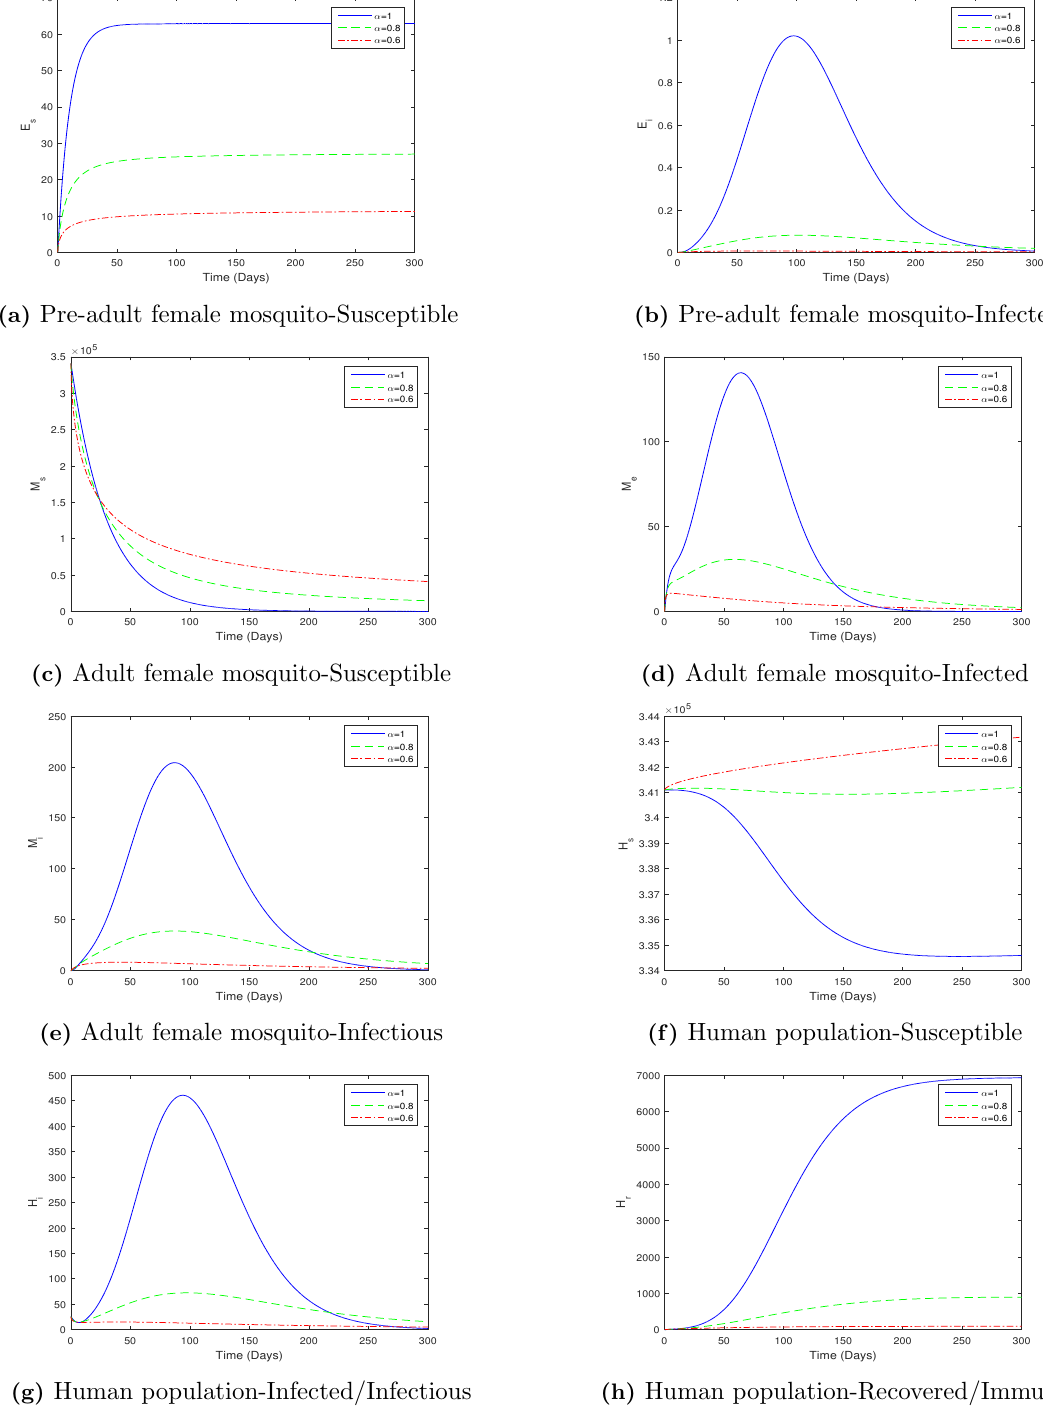
Figure 3. Simulation results of the fractional order dengue model at α = 1 , α = 0 . 8 , α = 0 . 6 at temperature 25 ◦